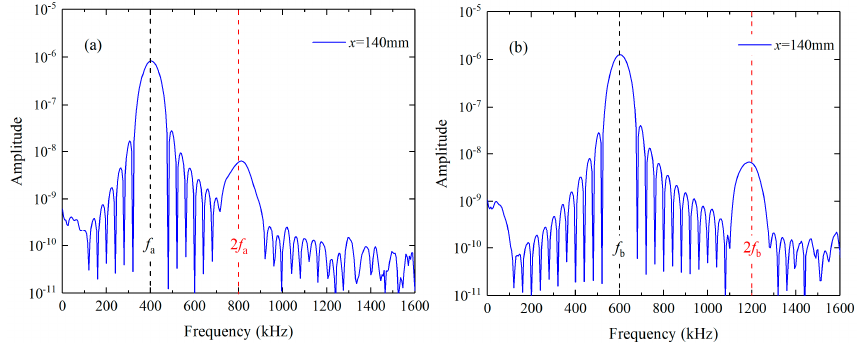
Figure 5. Frequency spectra of displacements along y axis at the same position in Case 2 ( a ) and Case 3 ( b ).